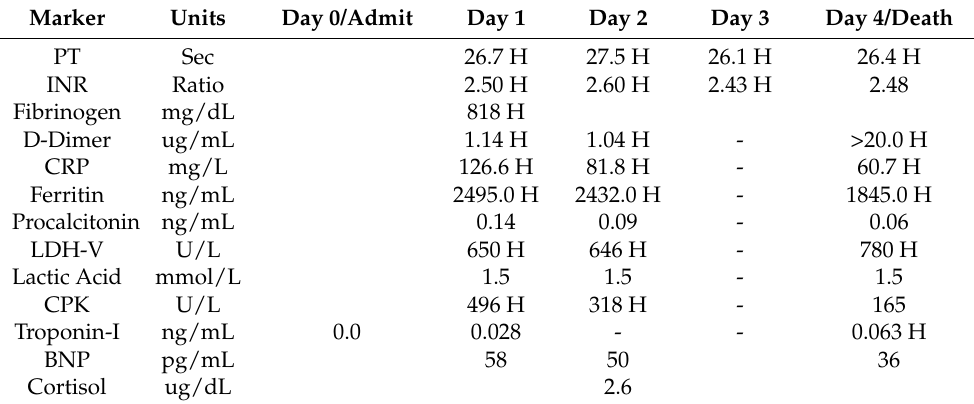
Table 2. Inflammatory labs